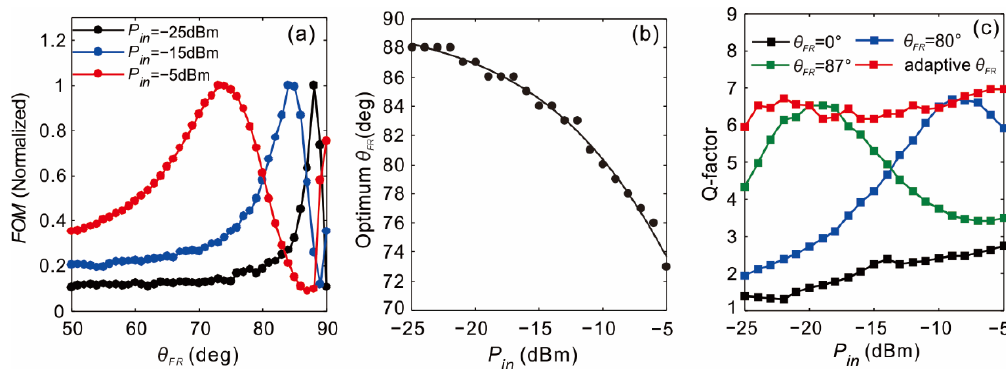
Figure 7. ( a ) Normalized FOM as functions of the rotation angle at different downstream signal input powers. ( b ) The optimum rotation angle as a function of the downstream signal input power. ( c ) The Q-factors obtained with an adaptive θ FR , a constant θ FR at 87 ◦ , a constant θ FR at 80 ◦ , and a constant θ FR at 0 ◦ , respectively, as a function of the downstream signal input power. The ER of the downstream input signal is 6 dB.